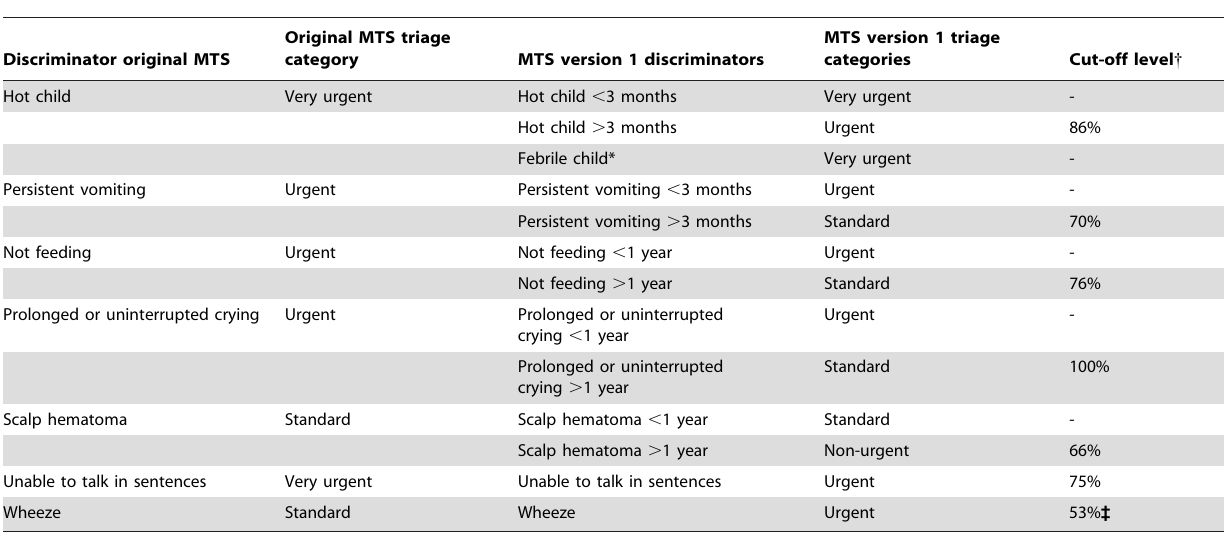
Table 1. Discriminator modifications for patients with high percentage of misclassification (MTS version